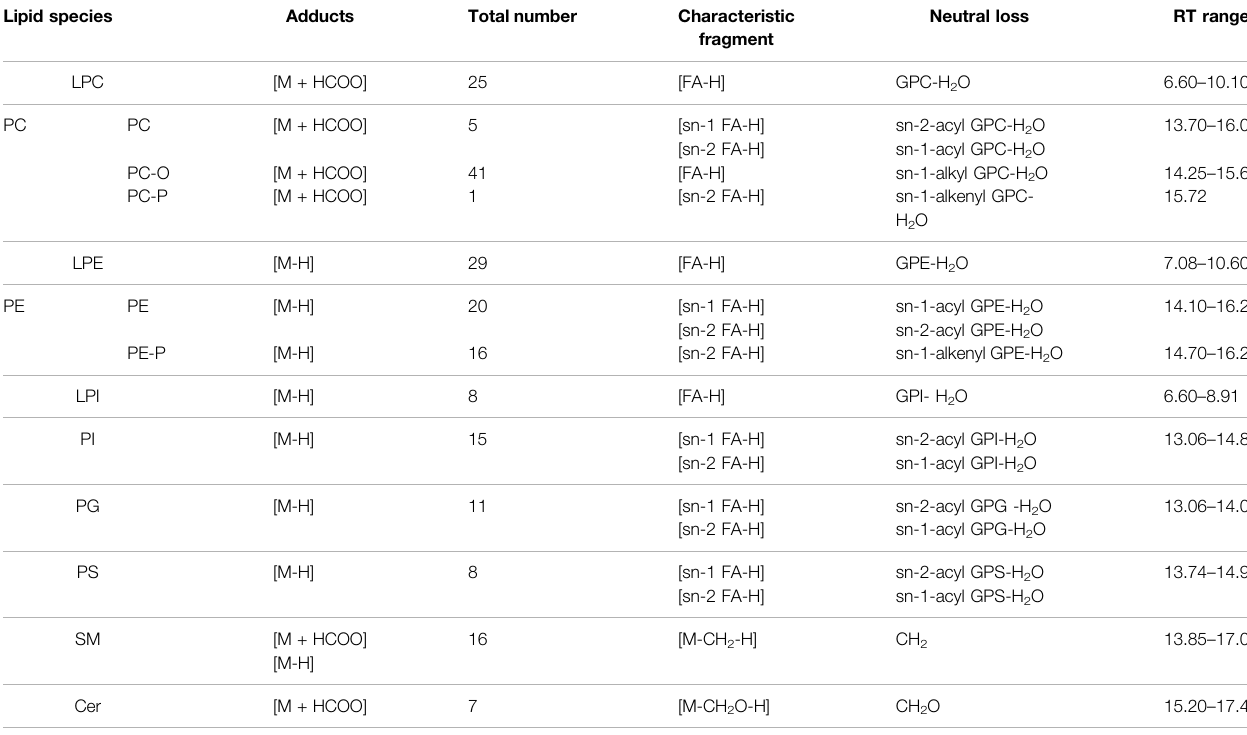
TABLE 1 | The summarized LC-MS characters of the lipid species in rat liver. Lipid